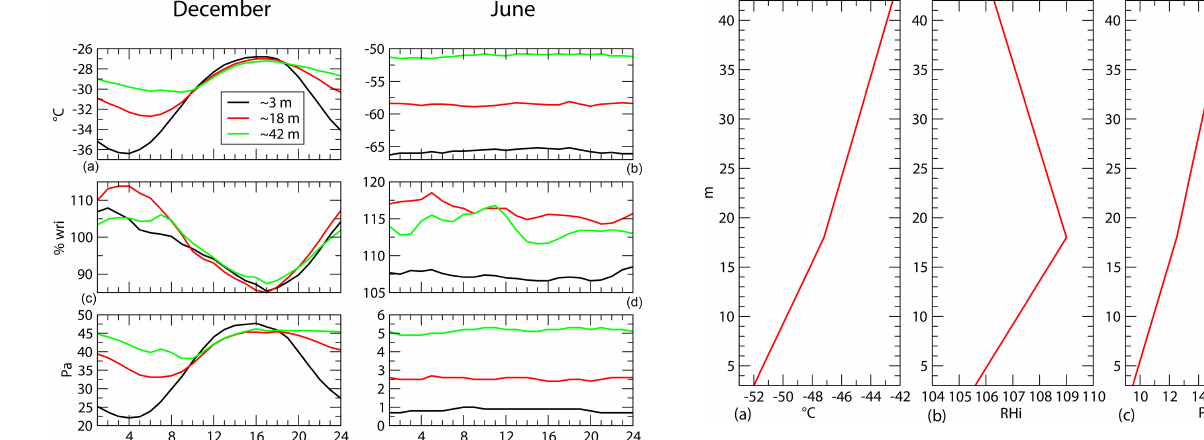
Figure 9. Annual mean vertical profile of temperature (a) , RHi (b) and PPW (c) for observations made from 2018 to 2020.